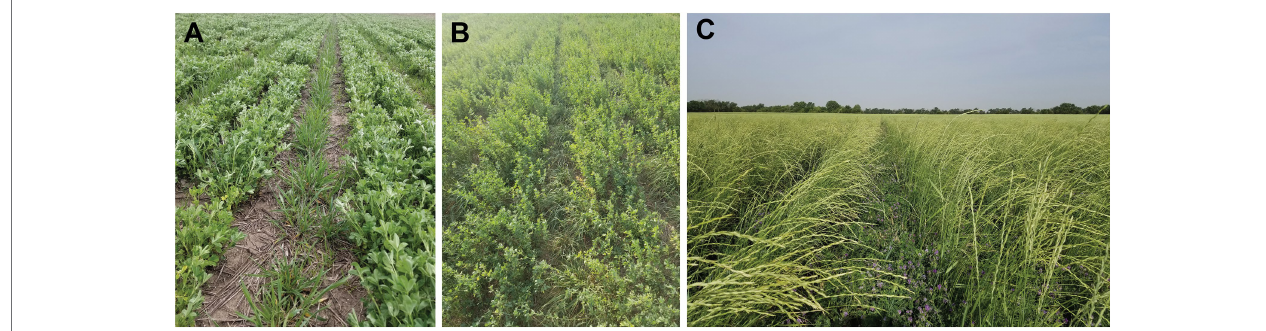
FIGURE 3 | Intermediate wheatgrass (IWG) intercropped with alfalfa for dual-purpose Kernza® perennial grain and forage production in a field near Canton, KS. The IWG is planted on 30-in rows with two rows of alfalfa (10 in apart) between each pair of IWG rows. Available spring ( A , April 6, 2020) and fall ( B , October 14, 2020) forage and ripening Kernza® perennial grain ( C , June 24, 2020) are